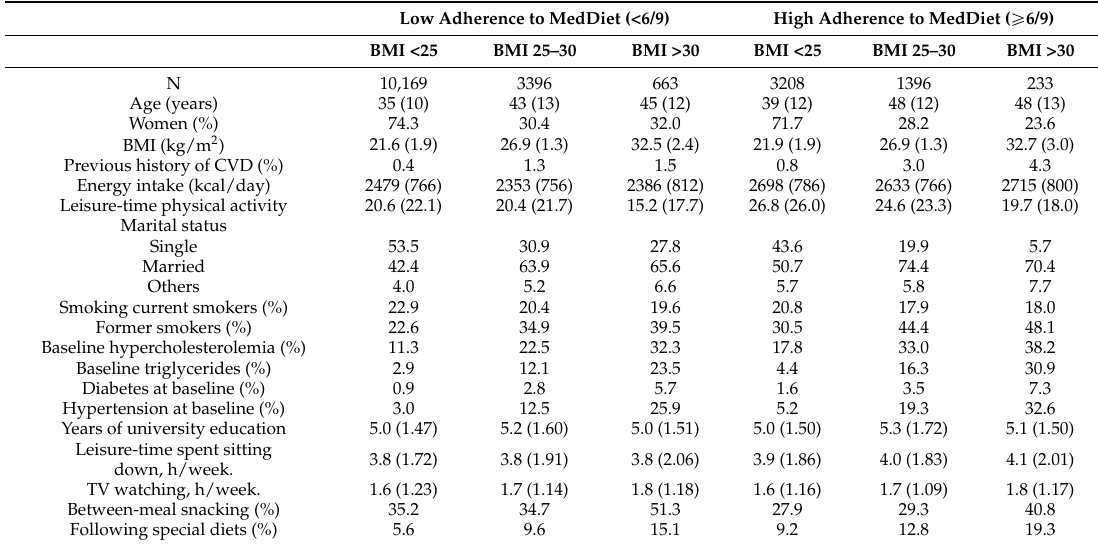
Table 1. Baseline characteristics of participants according to Mediterranean diet adherence and BMI. Low Adherence to MedDiet